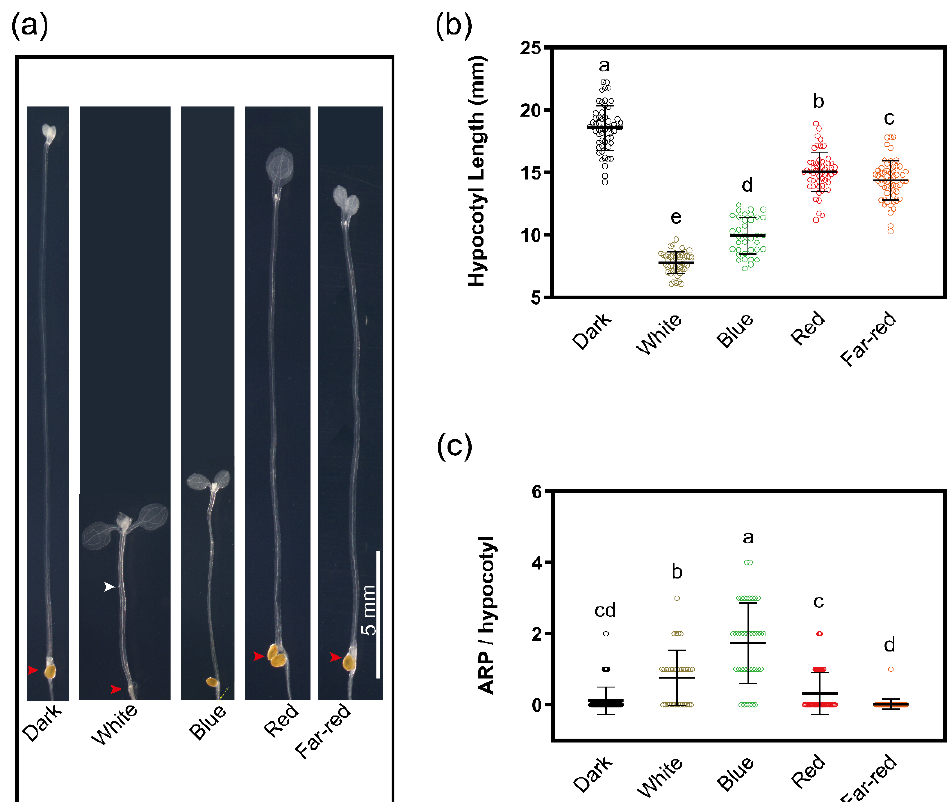
Figure 2. Hypocotyl elongation and adventitious root formation under different light sources. ( a ) Representative hypocotyl images of three-day-old etiolated WT (Col-0) seedlings that were illuminated with different LED light for 4 days. White arrowheads indicate ARPs, the red arrowhead points to the hypocotyl root junction. ( b ) Quantification of the hypocotyl length of the seedlings as in ( a ). ( c ) Quantification of the number of ARP in the hypocotyl of the seedlings as in ( a ). The data in ( b , c ) are represented as mean values ± SD, n -dark = 56; n -white = 34; n -blue = 38; n -red = 53; n -far-red = 51). Different letters indicate a significant difference at p ≤ 0.05 (ANOVA and LSD post hoc analysis). Scale bar: 5 mm. All images were taken at the same magnification.